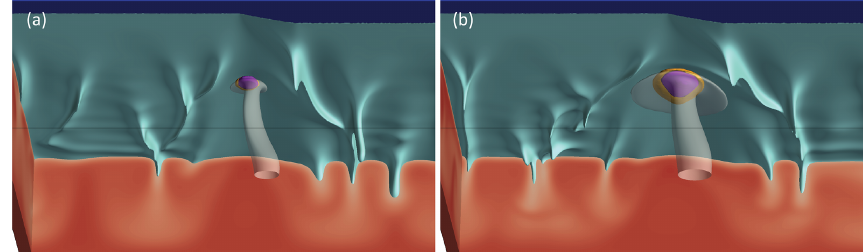
Figure 5. Steady-state snapshots of representative cases with different B plume but otherwise the same parameters as in the reference case (Fig. 3). (a) B plume = 50kgs − 1 ; (b) B plume = 200kgs − 1 . For reference to colors of surfaces and cross sections, see Fig. 3 caption and